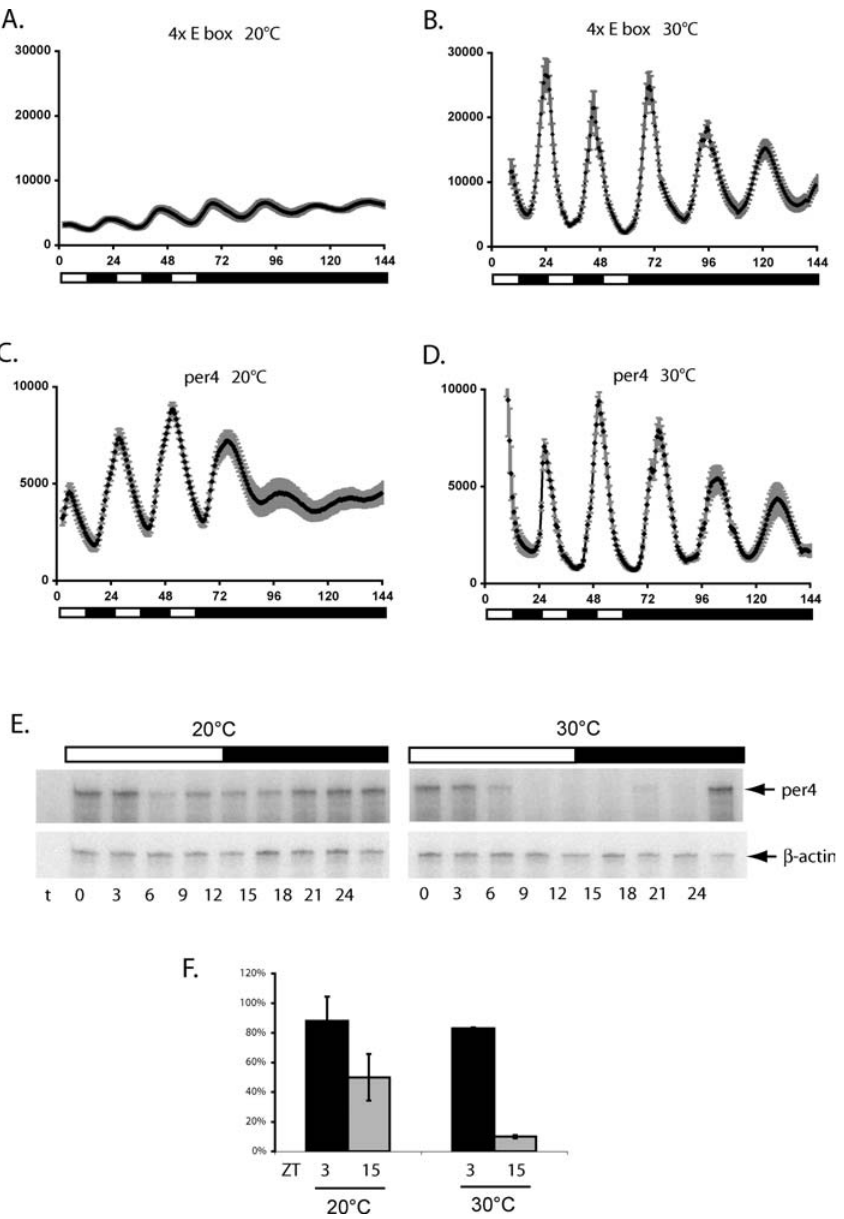
Figure 5. Temperature Compensation and the Amplitude of E-box-Directed Rhythmic Expression (A) Bioluminescence profile of 4xE-box ( (cid:1) 7) reporter cells held at 20 8 C under a LD cycle and then transferred to DD conditions. Plates were counted once per hour and maintained in robotic stacking units between assays, where they were illuminated. (B) Equivalent experiment to panel A, with cells maintained at 30 8 C. (C) Bioluminescence traces from 1.7-kb WT per4 reporter cells maintained at 20 8 C under LD cycle and DD conditions. (D) Bioluminescence traces from 1.7-kb WT per4 reporter cells maintained at 30 8 C under LD cycle and DD conditions. (E) RPA analysis of per4 expression in WT PAC-2 cells held at 20 8 C and 30 8 C under an LD cycle for 3 d. RNA extracts were prepared on the fourth day at 3-h intervals during one 24-h cycle. Time 0 represents ZT 0: the onset of the light period. A white and black bar above the autoradiograph indicates the duration of the light and dark periods. RPA results with a b -actin loading control are also shown. ‘‘ t ’’ represents a tRNA control sample. (F) A bar graph shows quantification of the peak (ZT3) and trough (ZT15) per4 expression values at 20 8 C and 30 8 C plotted as described in Figure 1, with error bars representing the standard deviation of three independent experiments. All bioluminescence traces represent the mean values of 16 independent wells. Each panel is representative of at least three independent experiments. DOI: 10.1371/journal.pbio.0030351.g005